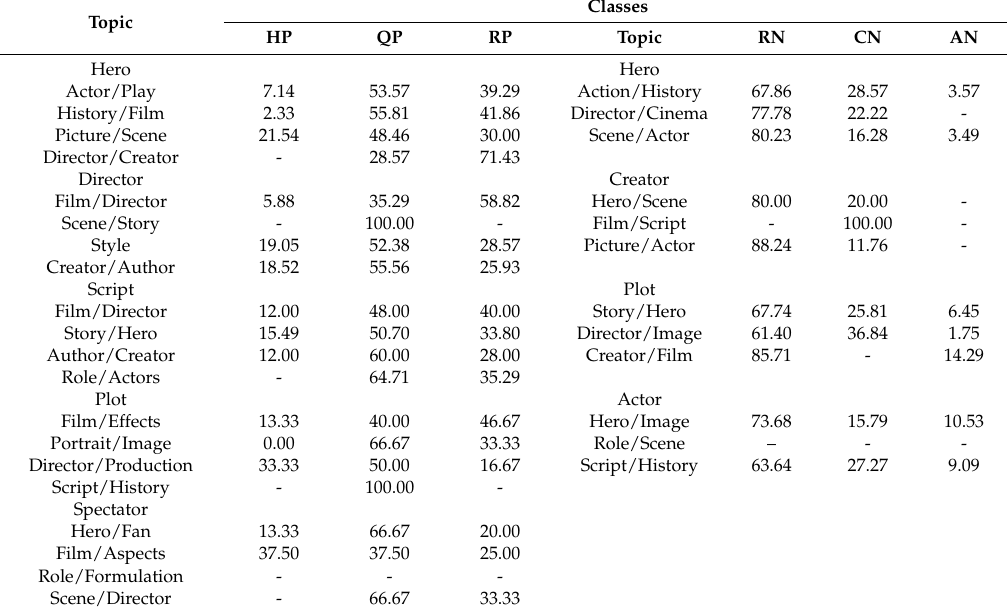
Table 20. Contextual Framework of the 2nd level of Film Reviews Corpora (% to the total number of